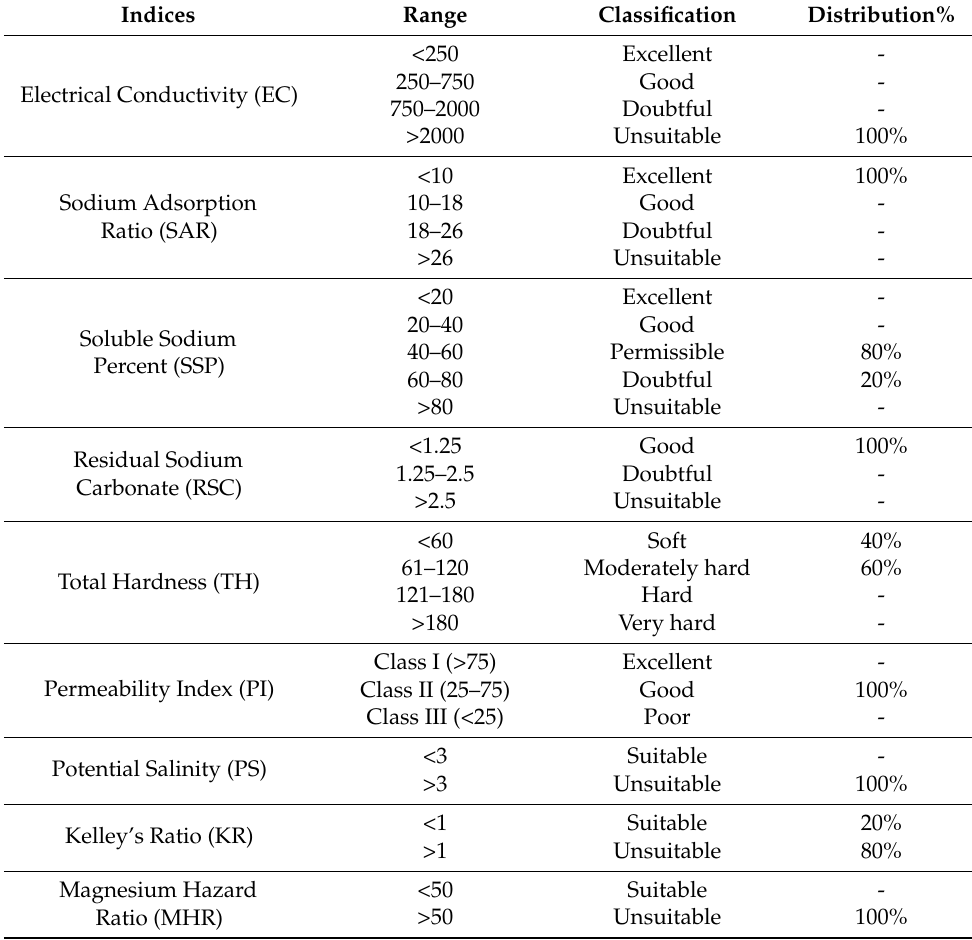
Table 7. Suitability classification for agricultural irrigation from